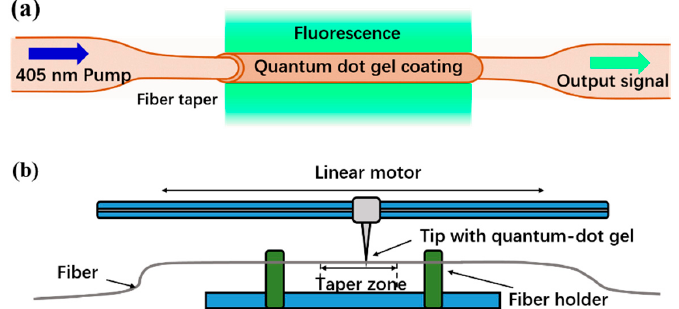
Figure 1. ( a ) The schematic diagram of the RH sensor; ( b ) the schematic diagram of the coating system developed for this study.